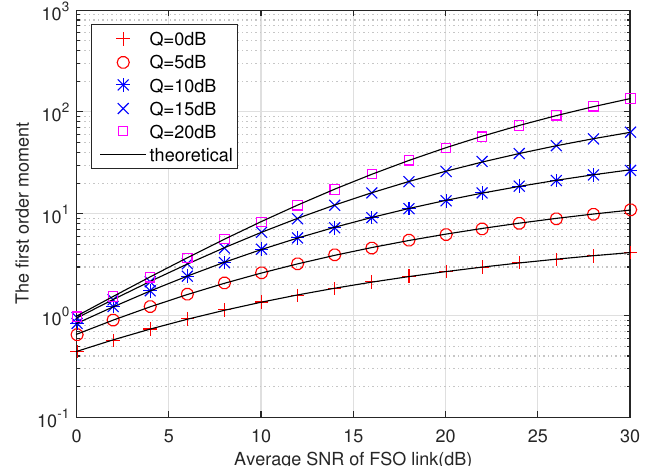
Figure 5. The first order moment of SNR under different interference threshold levels with heterodyne detection.